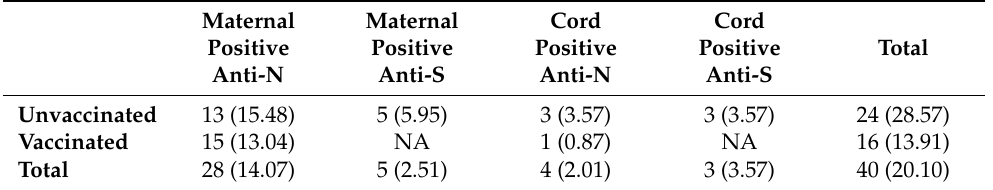
Table 3. Serological screening to detect pre-study maternal SARS-CoV-2 infections. Maternal Positive